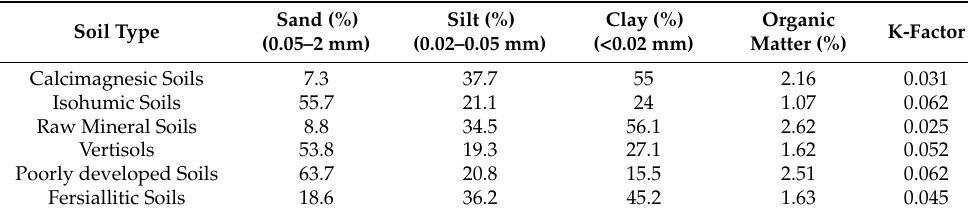
Table 3. Soil characteristics of study